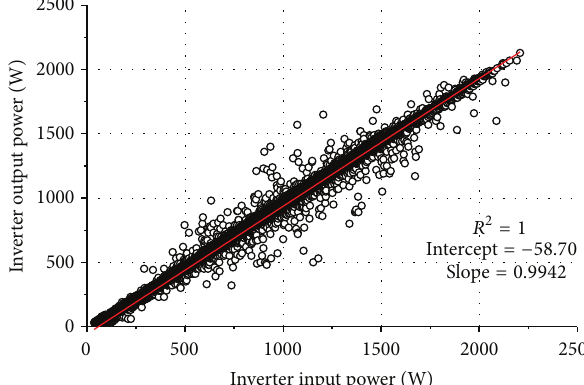
Figure 3: Relation between input and output power of